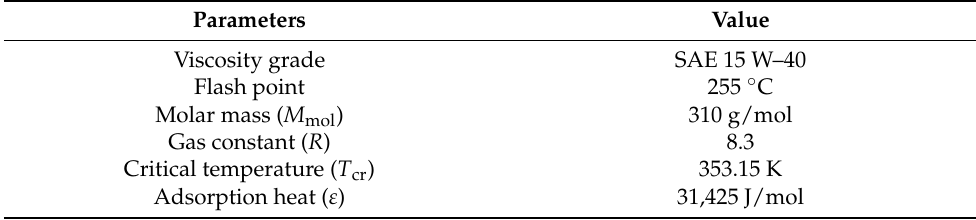
Table 1. ATF parameters